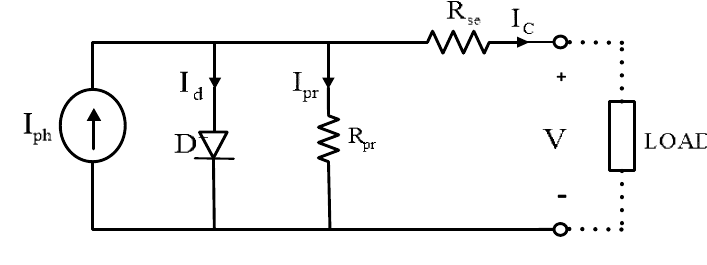
Figure 1. Equivalent circuit of PV cell.